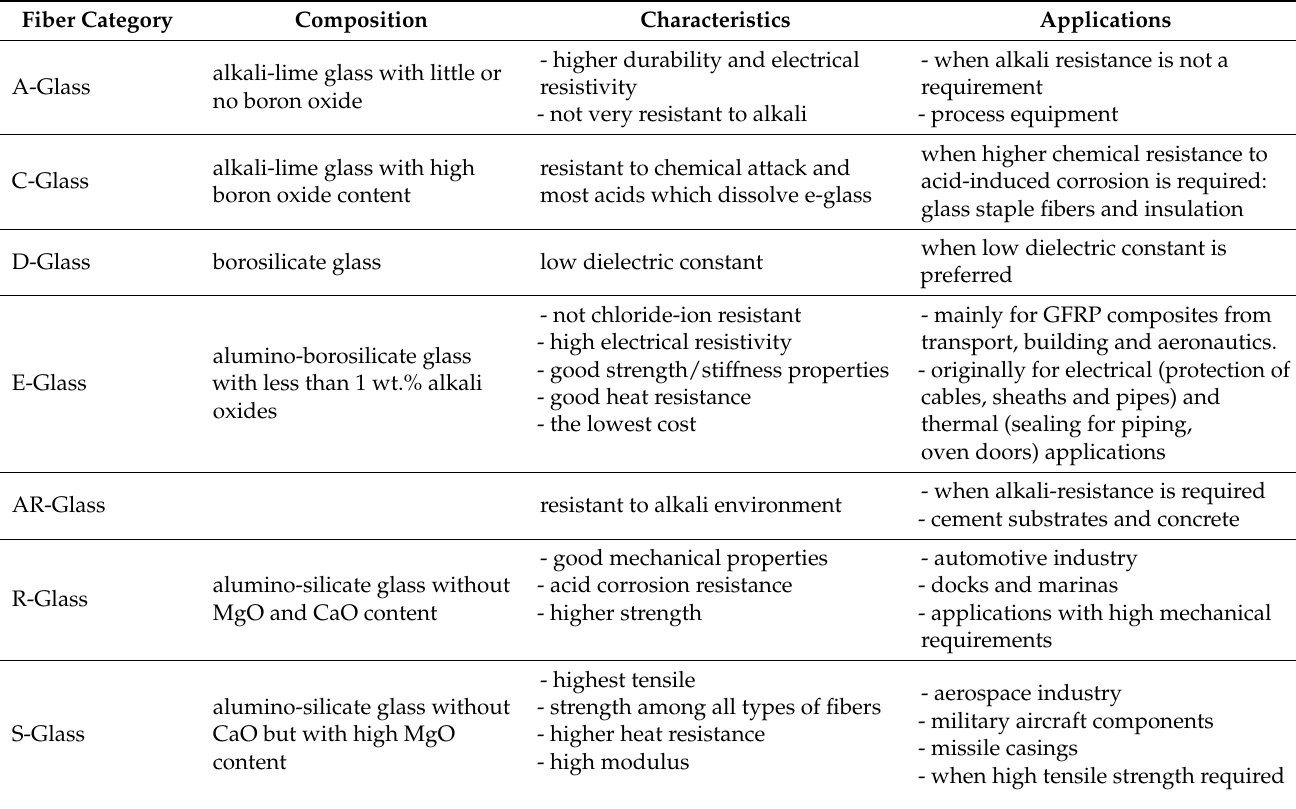
Table 1. Chemical composition, characteristics and main applications of glass fibers.